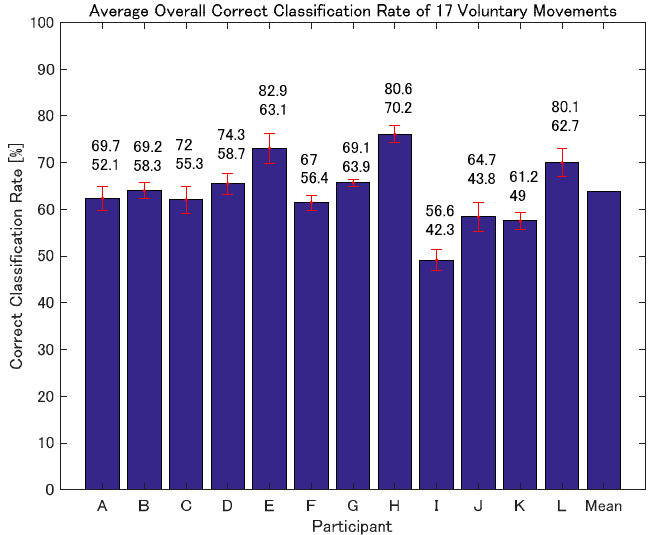
Figure 10. Average overall correct classification rate of 17 voluntary movements of 12 participants. The red error bars indicate standard deviation. The two numbers on top of the bars indicate highest and lowest overall correct rate. Note that the average correct rate of participant A, B, E and H are from the experiment on day 2 (best classification). Also, the mean overall correct rate indicates the overall correct rate across subjects.